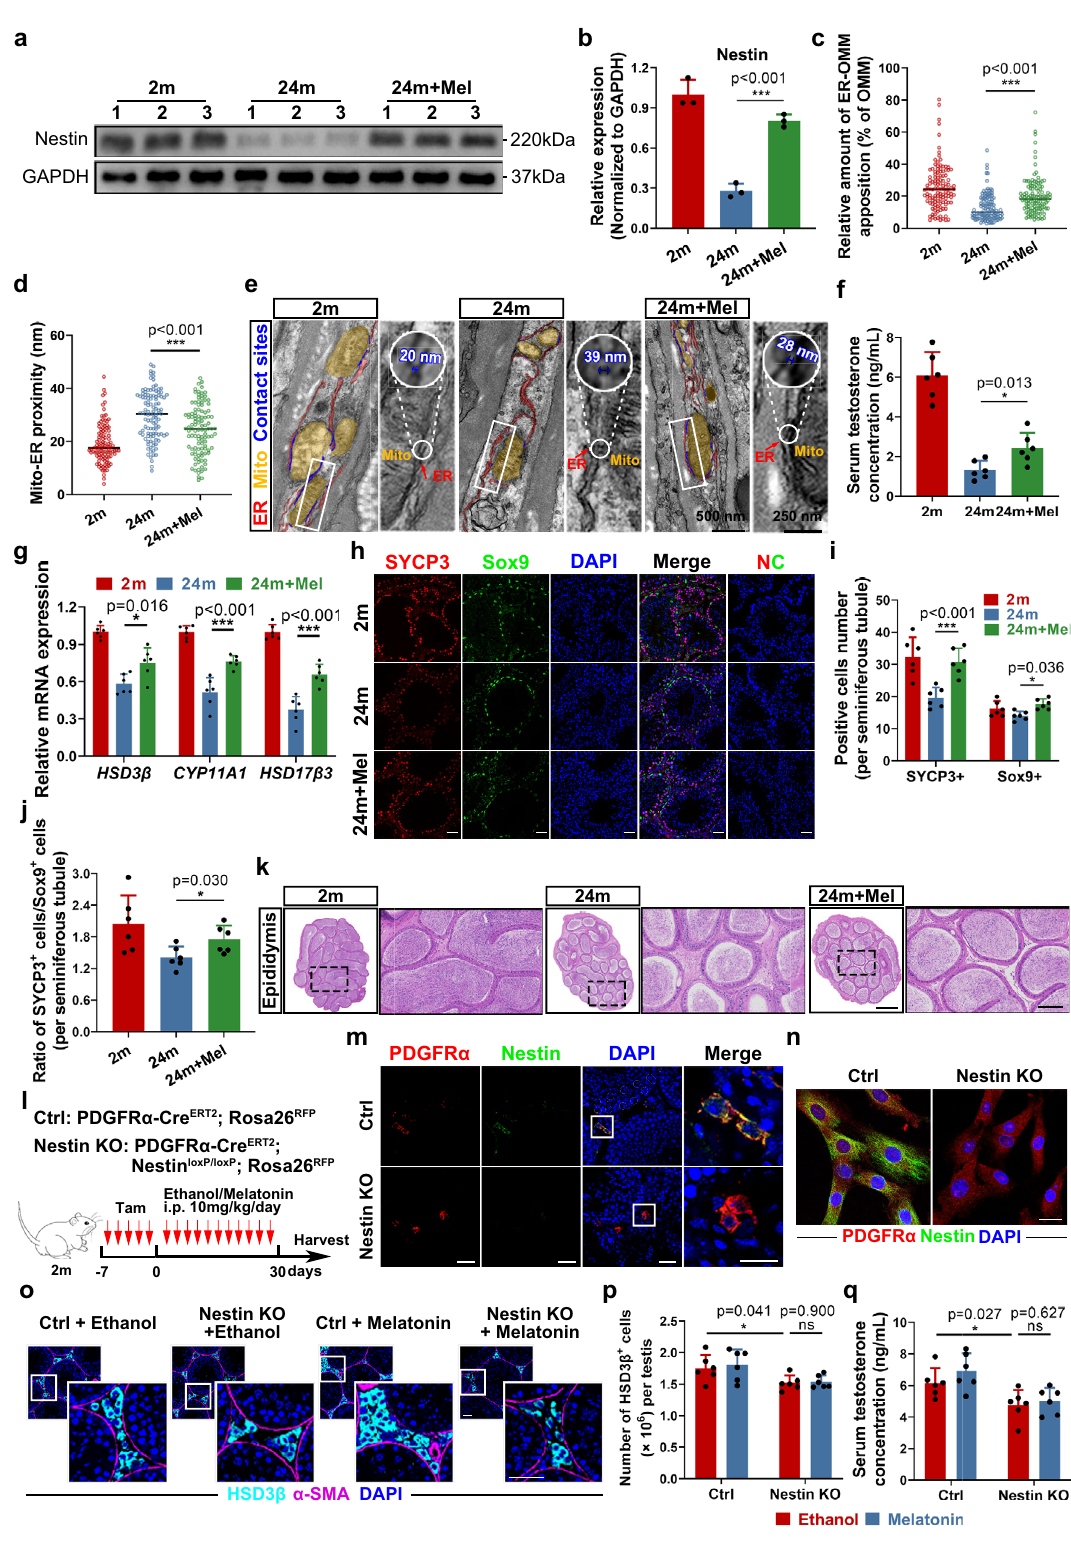
shown as a distinct fl uorescent spot and was analyzed by confocal microscopy. Control experiments included routine immuno fl uorescence staining of the proteins of interest under identical experimental conditions. PLA spots were counted in cell lines using software Blob fi nder version 3.2 90 . PLA scores were calculated by normalizing the number of PLA spots counted in each sample to the average number of PLA spots counted in the control sample, which was set to